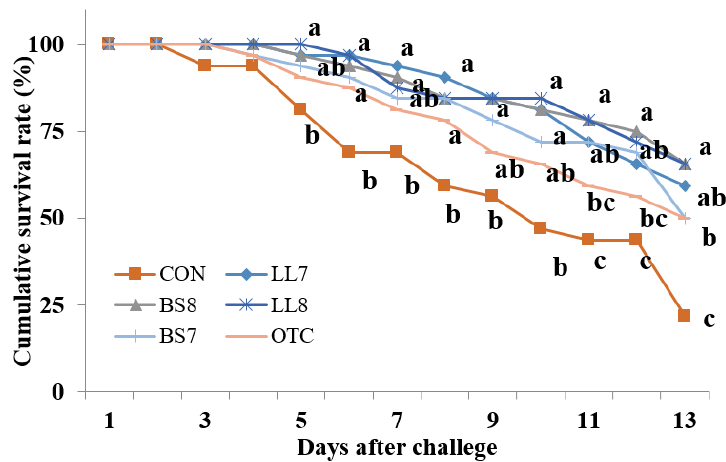
Figure 2. Cumulative survival rate of juvenile Nile tilapia fed the experimental diets with two probiotics for 8 weeks and experimentally challenged with A. hydrophila for 13 days. Each value represents mean of triplicate groups. Significant differences among means are indicated by different superscripts ( p < 0.05). For information on diets refer to Table 3